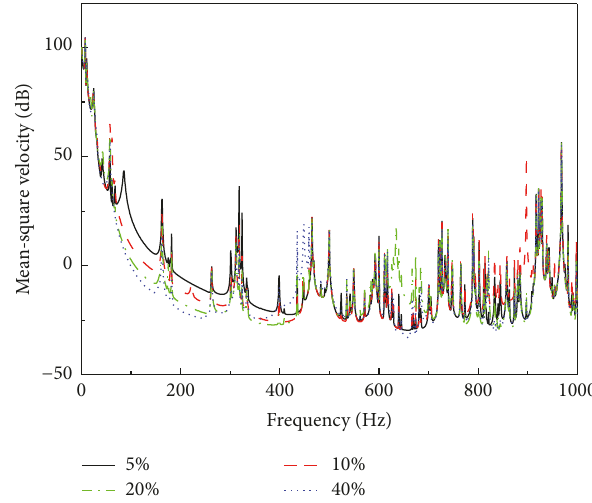
Figure 11: Effects of the mass of attached pipes on the synthesized